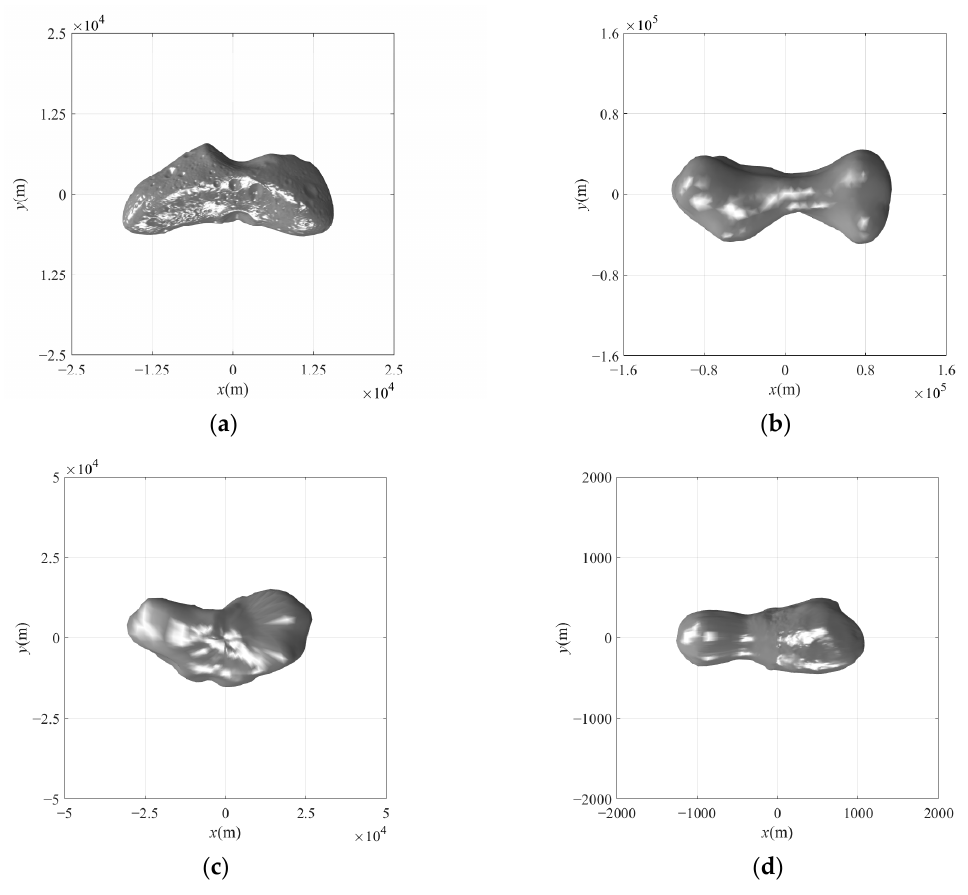
Figure 15. Polyhedral models corresponding to points 9–12 in Figure 12. ( a ) 433 Eros. ( b ) 216 Kleopatra. ( c ) 243 Ida. ( d ) 103P/Hartley. Table 5. The shape entropies of polyhedral models of small bodies.